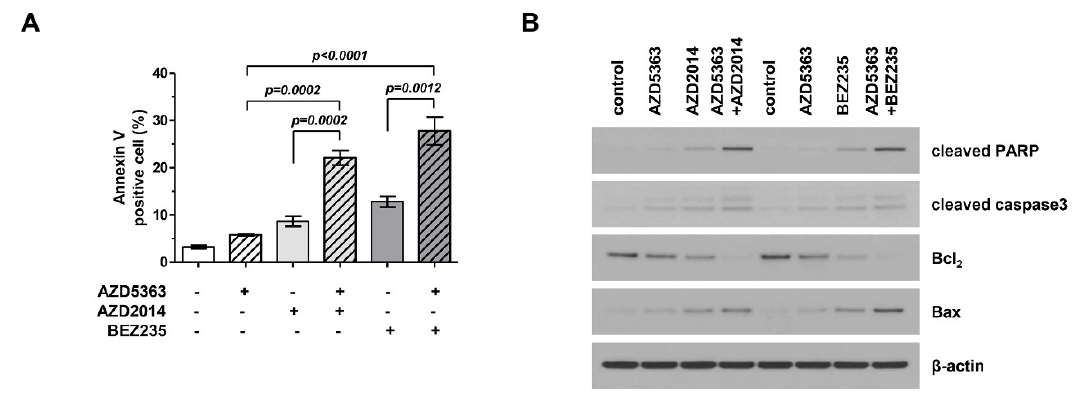
Figure 4. Effects of the combination therapy with an AKT inhibitor (AZD5363) and mTOR inhibitors (AZD2014 and BEZ235) on the apoptosis of PI3KCA and mTOR-mutated bladder cancer cells. ( A ) The combination therapy increased the apoptosis of J82 cells. Apoptosis was detected using Annexin V/propidium iodide staining. Cells were exposed to AZD5363 (3 μM), mTOR inhibitors (1 μM AZD2014 and 0.5 μM BEZ235), or a combination of both for 48 h. ( B ) Pro-apoptotic protein expression was detected by Western blotting. J82 cells were treated with AZD5363 and mTOR inhibitors for 48 h. Proteins were extracted and Western blotting was performed for cleaved PARP, cleaved caspase-3, Bcl-2, and Bax. β-Actin was used as the loading control.